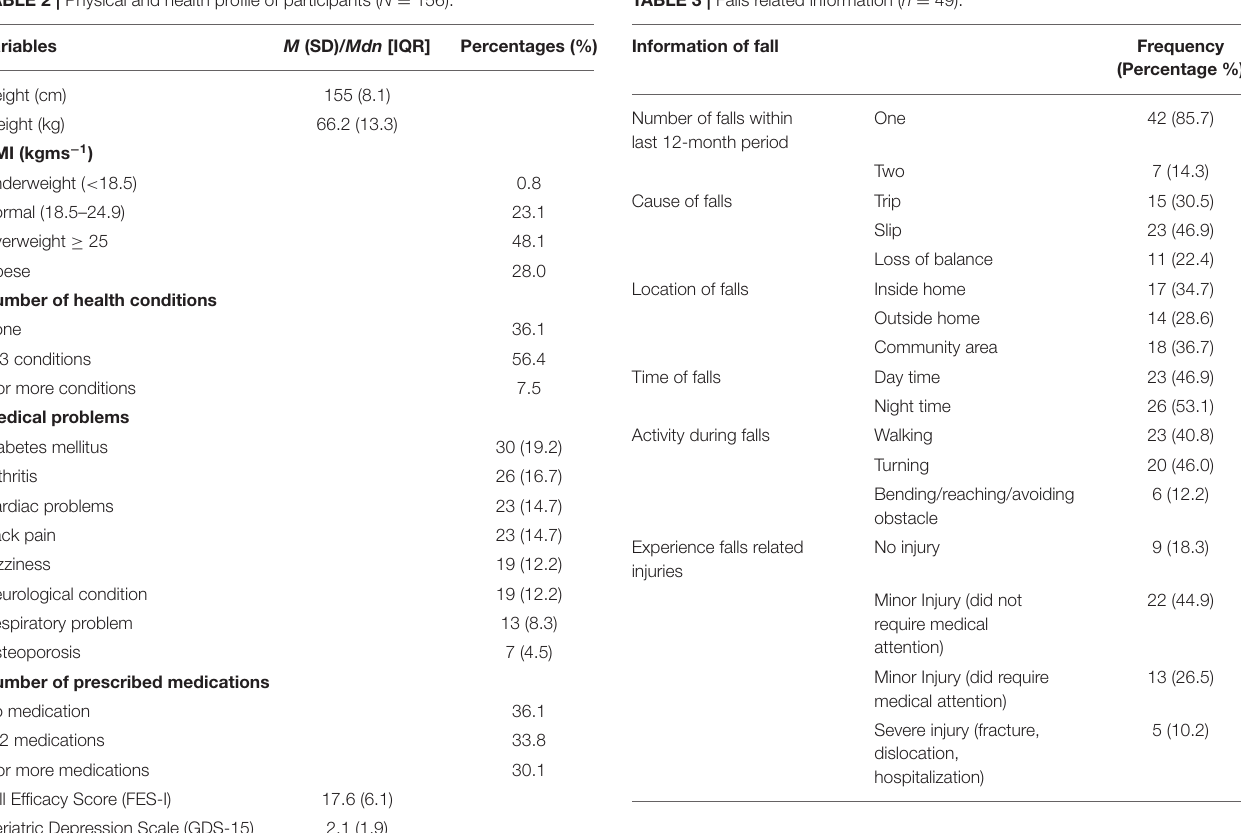
TABLE 2 | Physical and health profile of participants ( N = 156). TABLE 3 | Falls related information ( n =